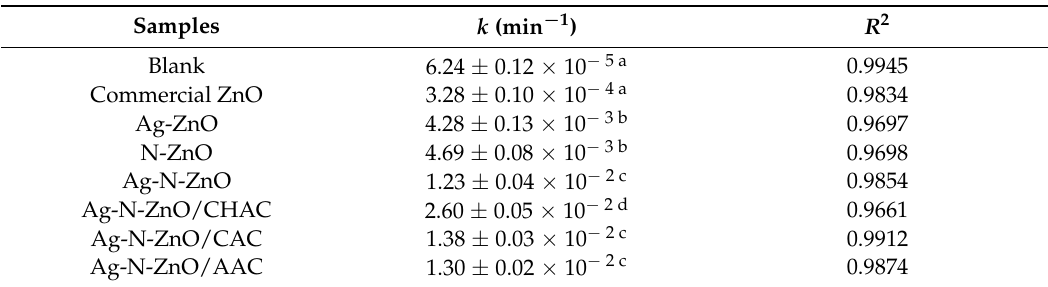
Table 3. First order kinetic constants and relative coefficients for photocatalytic degradation of MO over the samples.